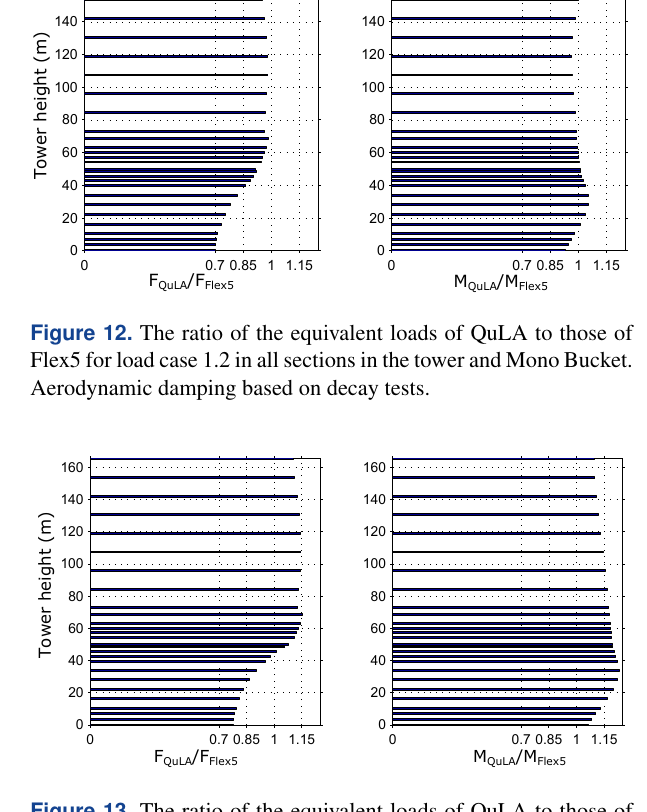
Figure 13. The ratio of the equivalent loads of QuLA to those of Flex5 for load case 1.2 in all sections in the tower and Mono Bucket. Aerodynamic damping based on standard deviation of tower top